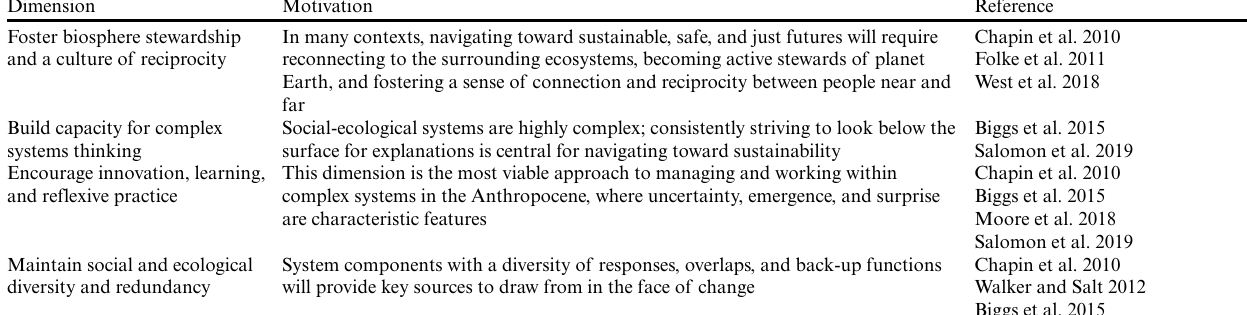
Table 1. Seven option space dimensions and the features that contribute to the long-term capacity to navigate change.